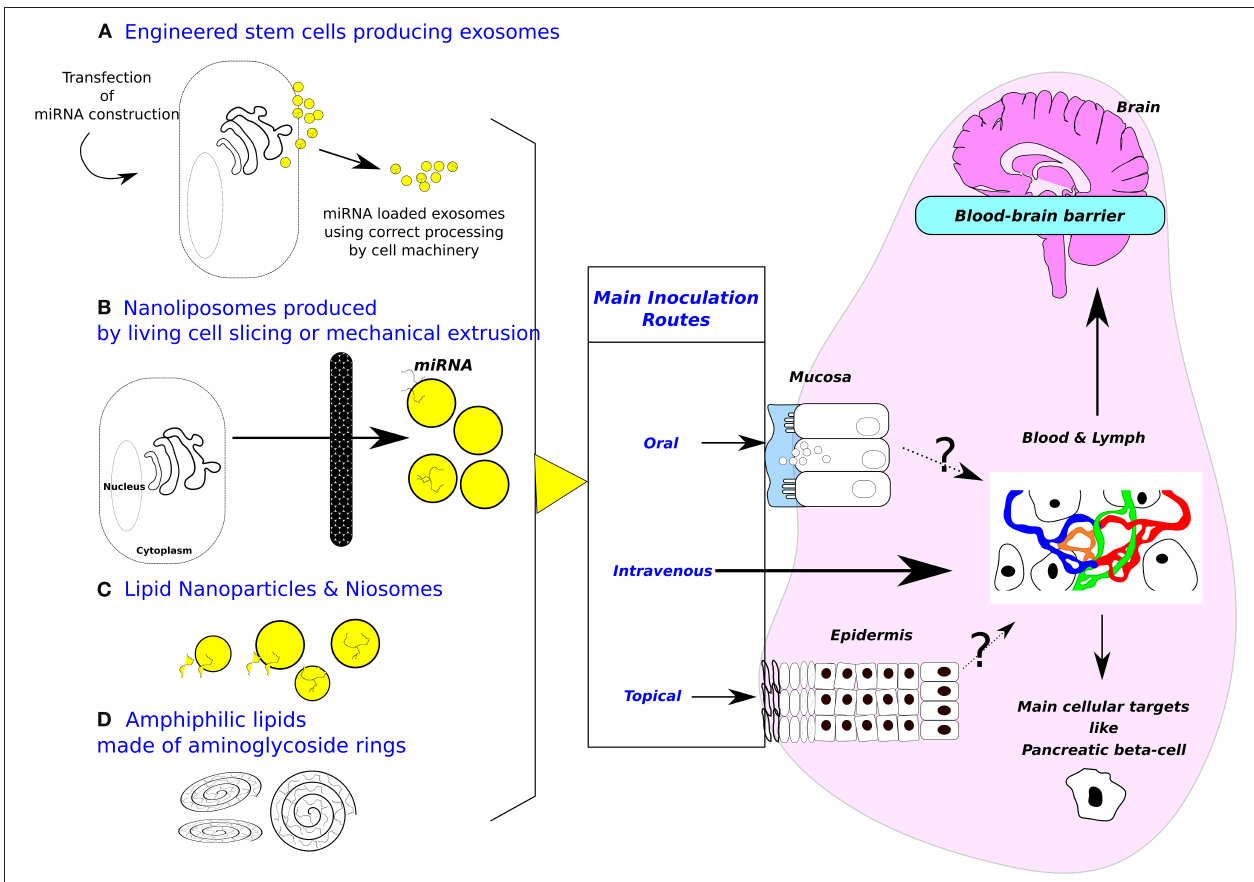
FIGURE 1 | Sources of exosomes and design of biomimetic vehicles. Purposes of inoculation routes are (1) minimizing invasiveness, (2) targeting cell-specific (i. e., gut or beta pancreatic cells) or tissue-specific delivery (i. e., brain). (A) Engineered cells for producing exosomes. (B) Nanoliposomes produced from living cells. (C) Lipid nanoparticles & Niosomes (Diameter between 10–100nm, made with non-ionic surfactants including alkyl esters, ethers, and amides.). Most applications are targeting T lymphocytes or dendritic cells. Beside these attempts to mimic more or less closely natural exosomes, amphiphilic lipids made of aminoglycosides rings (D) are also used to deliver nucleic acid in target cells, the main application being vaccination. Mechanism of cytosol delivery has been studied under electron microscopy ( 23). Moreover, oral inoculation opens the possibility to target digestive epithelial cells (24). Note that blood-brain barrier at the plexus choroid can relay signal received from circulating exosomes by producing de novo exosomes liberated in brain area (25). A cellular target could be pancreatic beta-cells, the cell surface proteome has been described (26) opening the way to specifically address biodesigned nanoparticles loaded with miRNAs. Patients undergoing bariatric surgery are frequently recovering from type-2 diabetes, strongly suggesting that gastrointestinal epithelium is crucial in such pathology and opening the way for treating metabolic diseases by oral delivery of drugs (27).